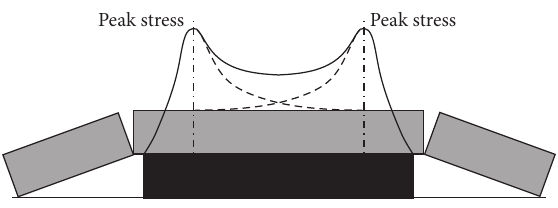
Figure 8: Abutment pressure distribution of the coal